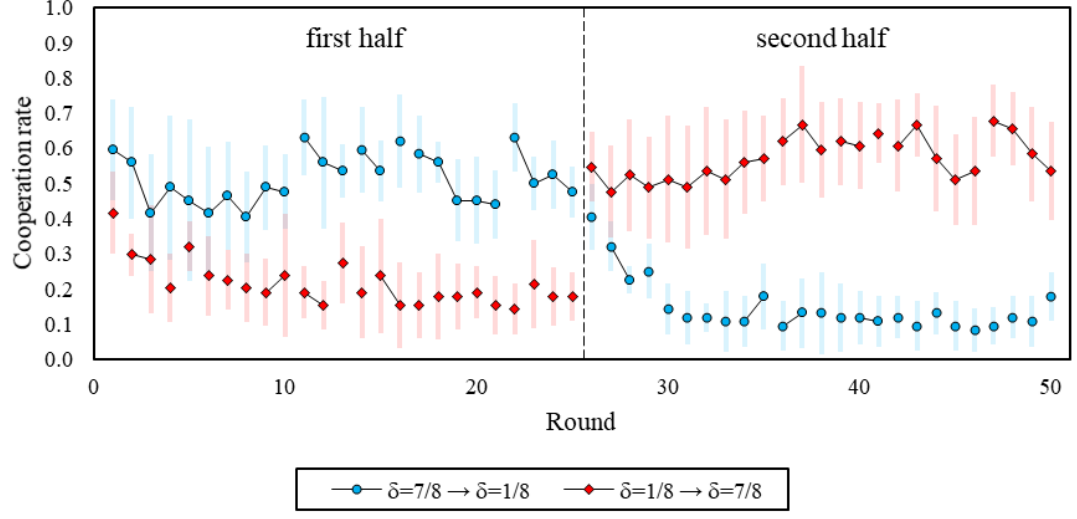
Figure 2. Cooperation over the course of the session, by treatment. Lines between dots represent rounds of a single interaction. In addition, 95% confidence intervals clustered by session.